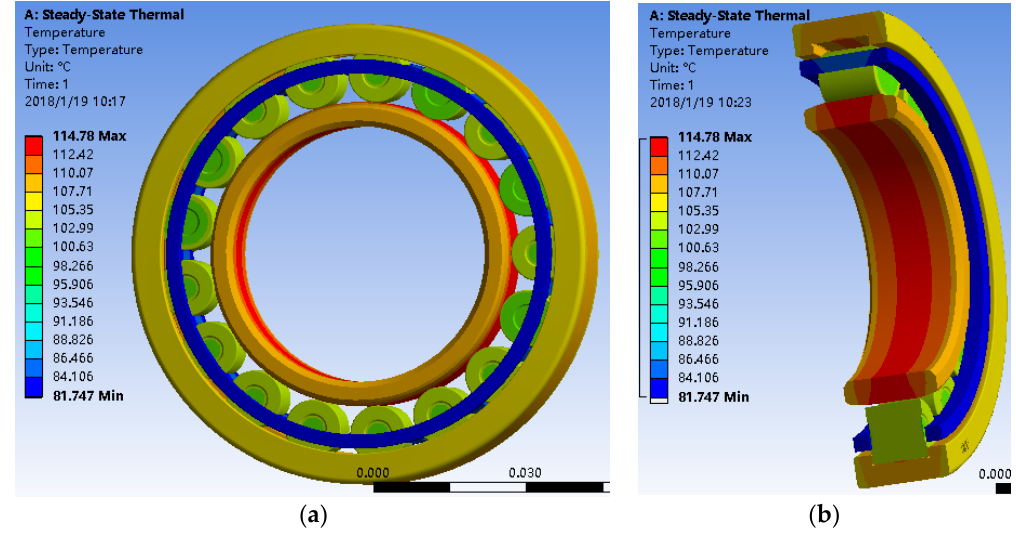
Figure 9. Steady-state temperature distribution of the bearing. ( a ) Front view; ( b ) section view.